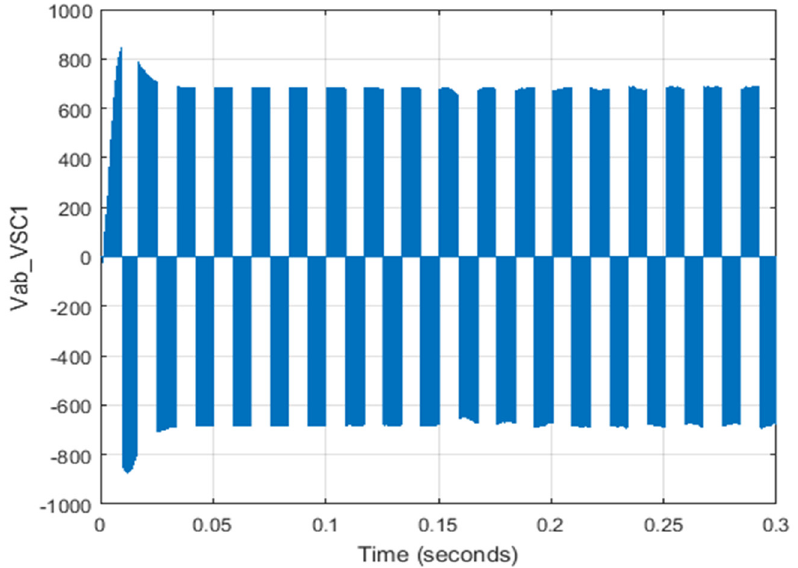
Figure 10. Two-phase voltage ab for VSC-1.